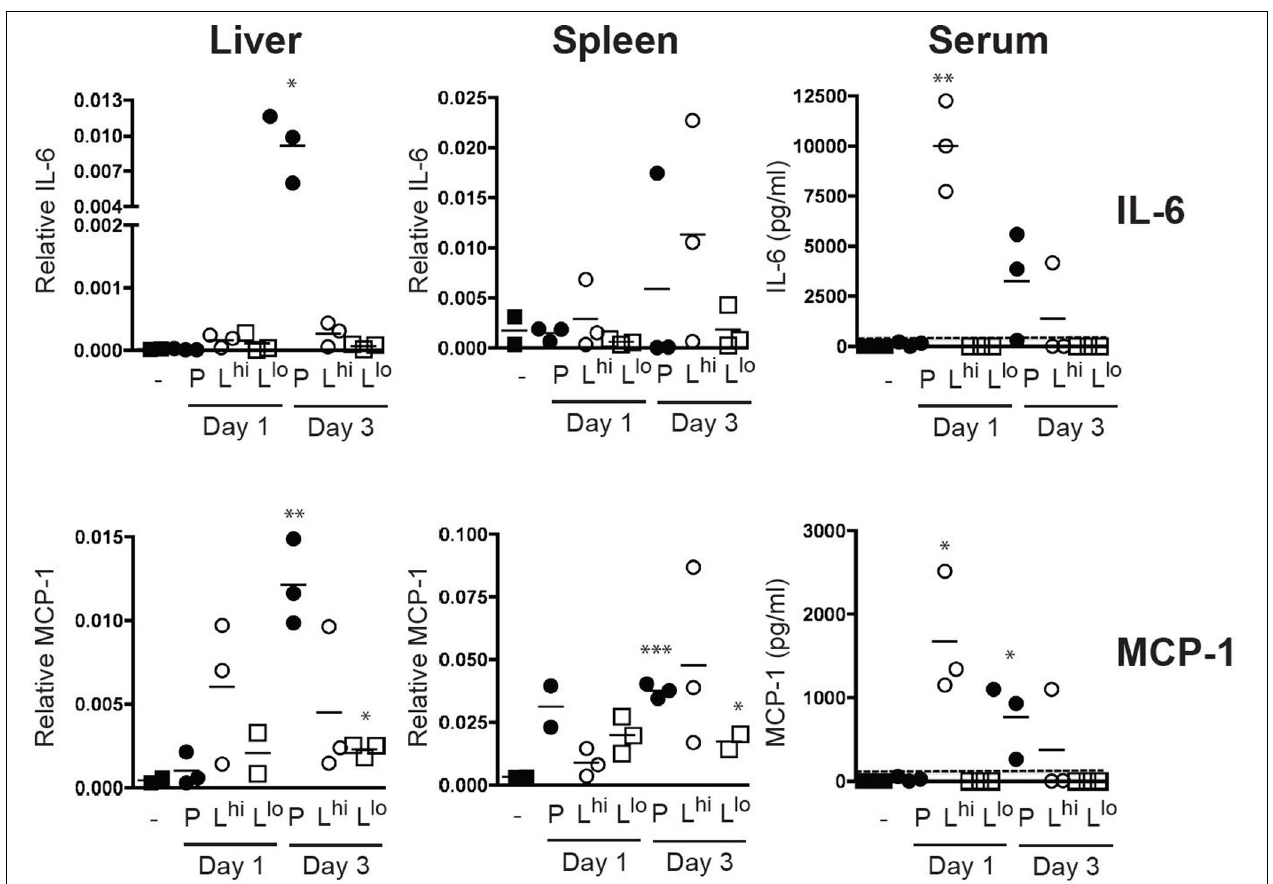
FIGURE 8 | IL-6 and MCP-1 production in BALB/c mice challenged by intraperitoneal injection of 0.5ml protoplast buffer plus soft agar (3/1; v/v) containing 100 cfu parental (P) L. monocytogenes , 10 8 cfu L-forms as high dose (L hi ) or 10 5 cfu L-forms as low dose (L lo ). Control animals received 0.5ml protoplast buffer plus soft agar (3/1; v/v) alone. Cytokine mRNA expression values were